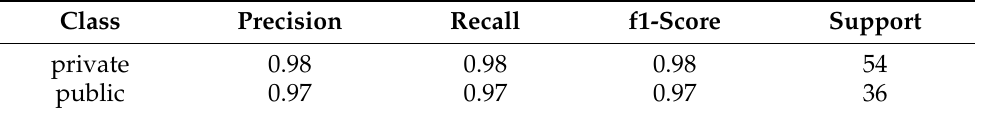
Table 4. Precision, recall and f1-score of the multi-level model including land use tags as well as benches, playgrounds, density of footpath intersections and the access=* tag as context indicators. Support indicates the number of test samples of each class.